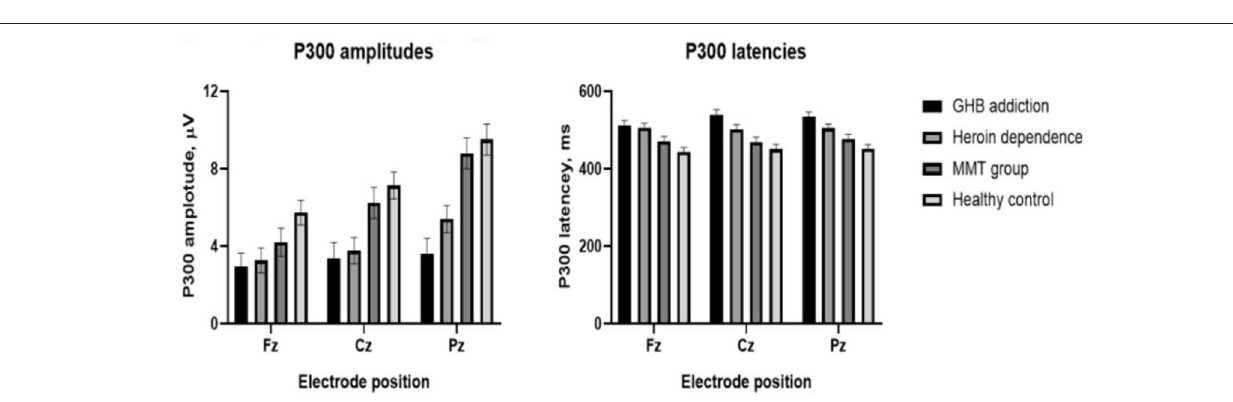
FIGURE 3 | Means and standard deviation scores by groups. Group means and standard deviation (M ± SD) for P300 amplitudes (left); group means and standard deviation (M ± SD) for P300 latencies